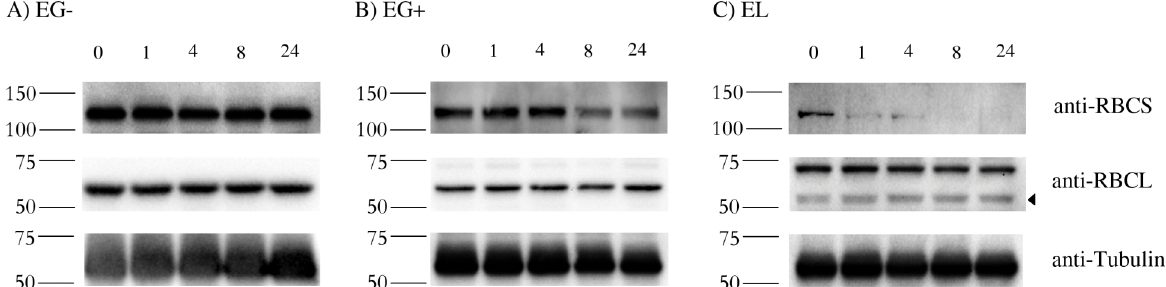
Fig 4. Stability of RBCS and RBCL proteins in Euglena gracilis and Euglena longa . Cell cultures were treated with 20 μ g/ml of cycloheximide, aliquots were taken at 0, 1, 4, 8, and 24 h post treatment, and analyzed by western blotting using anti-RBCS, anti- RBCL and anti-Tubulin antibodies. Molecular weights (in kDa) are indicated on the left of each panel. The identity of the RBCL protein (arrowhead in the anti-RBCL panel) was confirmed by mass-spectrometry. Tubulin served as a loading control. Cultivation conditions and species are denoted as in Fig